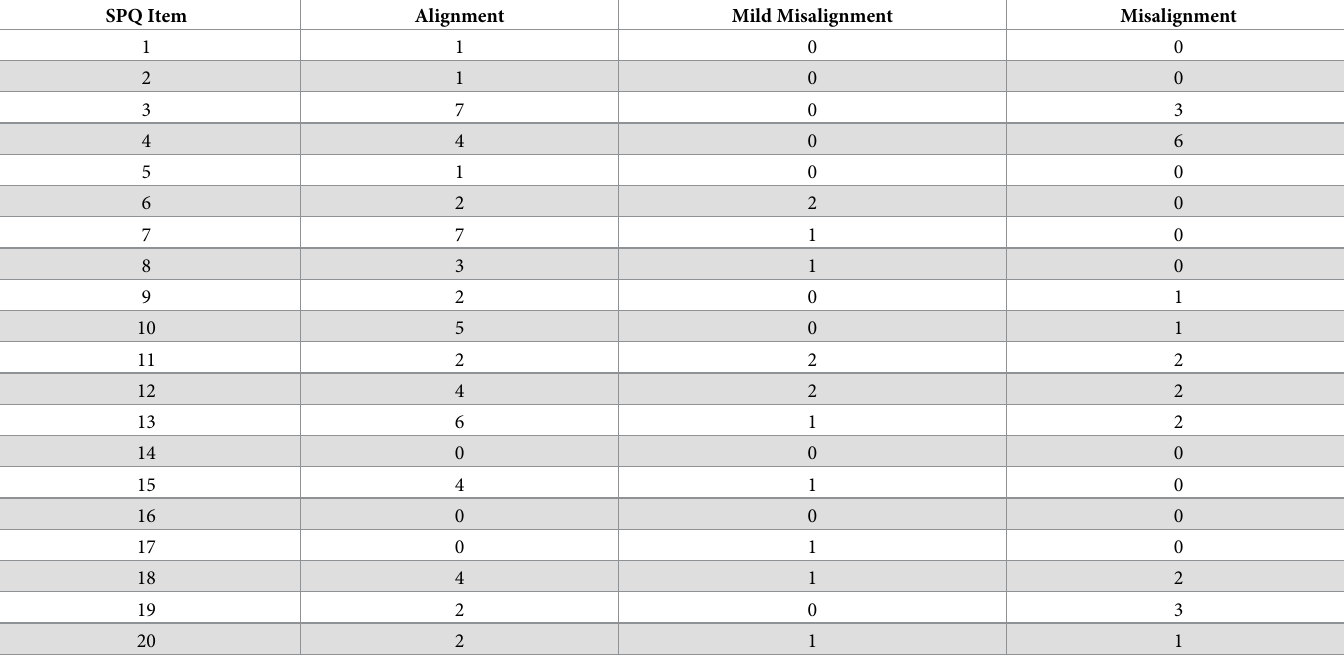
Table 3. Alignment between qualitative interview data and quantitative SPQ responses for all participants. SPQ Item